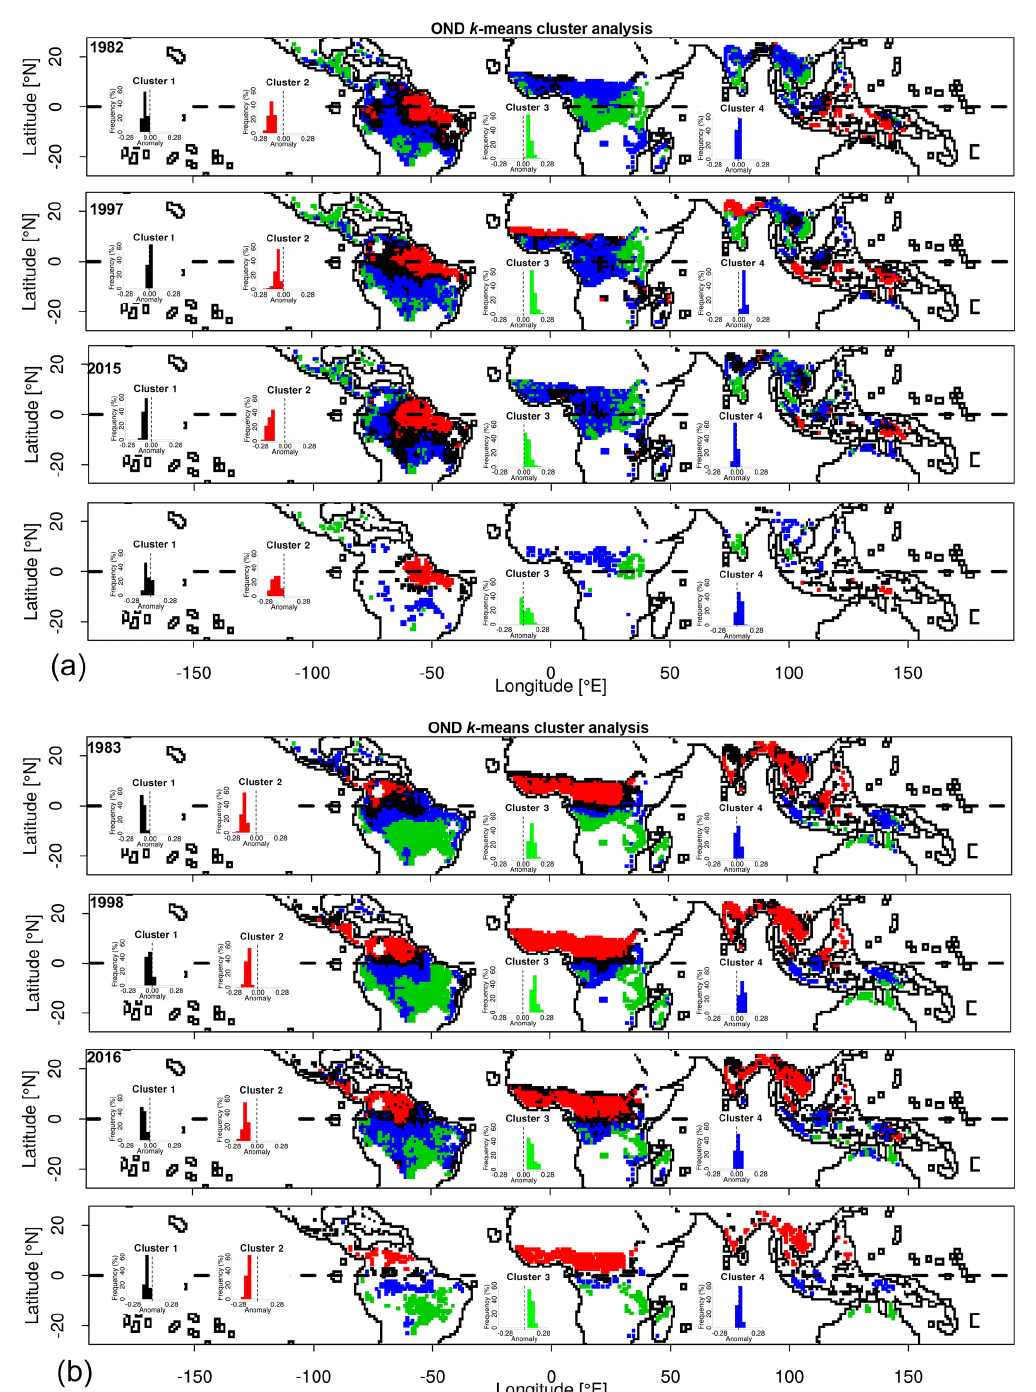
Figure 6. (a) k -Means cluster analysis results for the October-to-December (OND) 1982, 1997 and 2015 El Niño events and the overlap of the three periods. Corresponding histograms of soil moisture anomalies for each of the four clusters are also shown. Anomalies relative to the 1979–2016 period. (b) Same as (a) but for January to March (JFM) in 1983, 1998 and